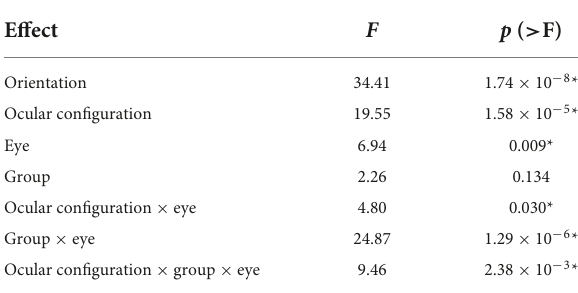
TABLE 3 Omnibus ANOVA